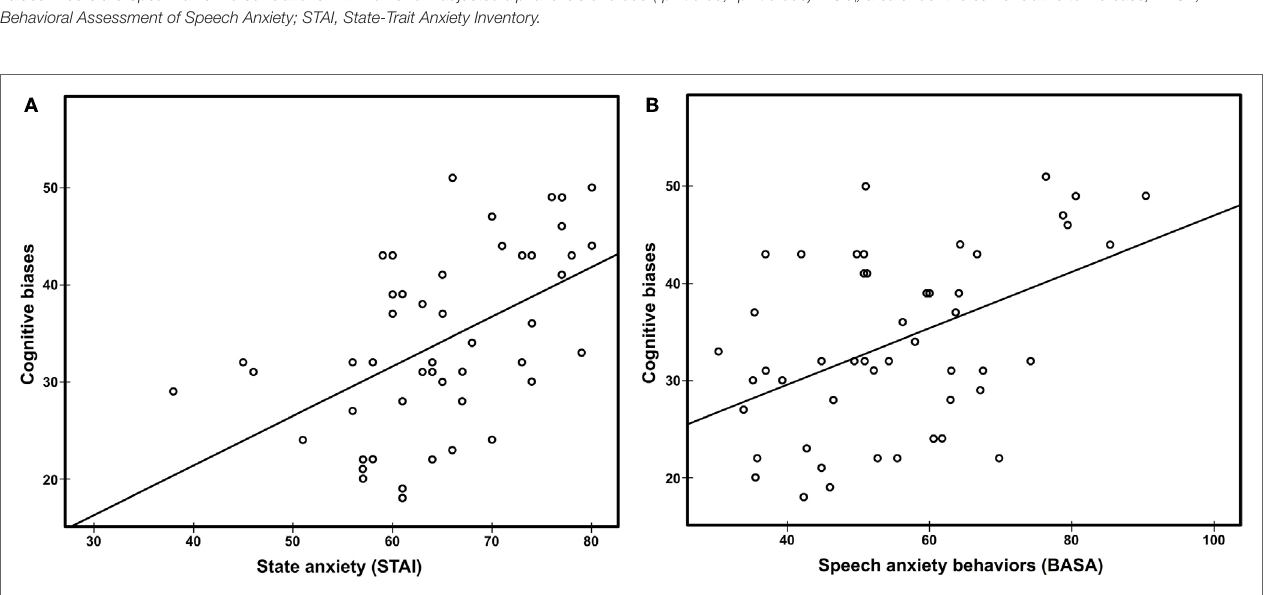
FigUre 4 | scatter plot of cognitive biases against state anxiety (a) r s = 0.55, p < 0.008 and speech anxiety behaviors (B) r s = 0.42, p < 0.008 . STAI, State-Trait Anxiety Inventory; BASA, Behavioral Assessment of Speech Anxiety.